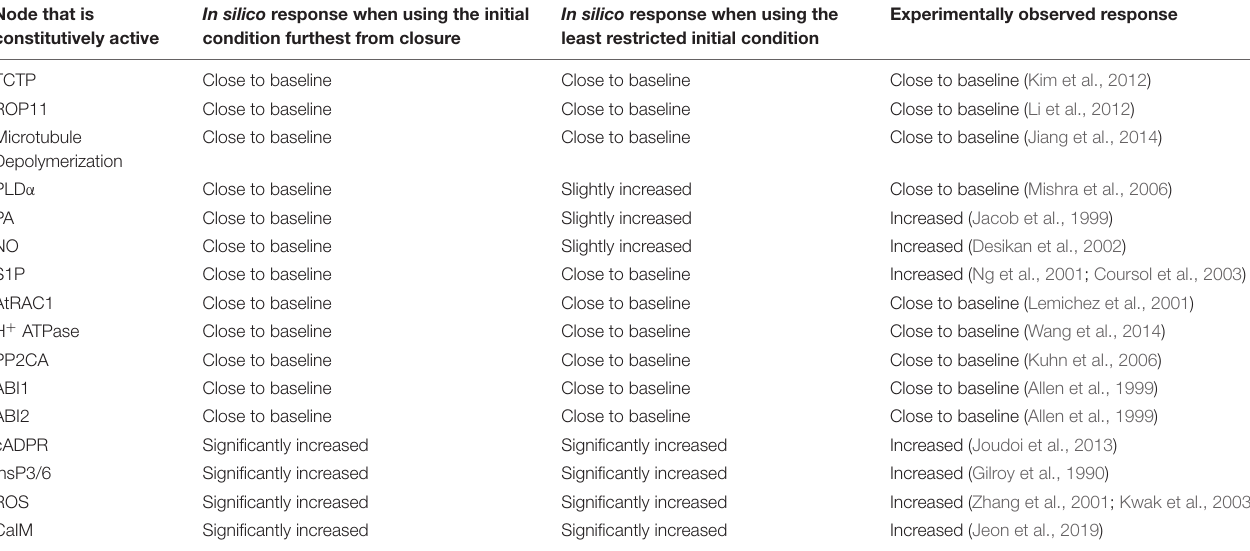
TABLE 1 | Comparison between experimental results and simulation results in Model1 with short-term memory for constitutive activation of nodes in the absence of ABA. Node that is In silico response when using the initial constitutively active condition furthest from